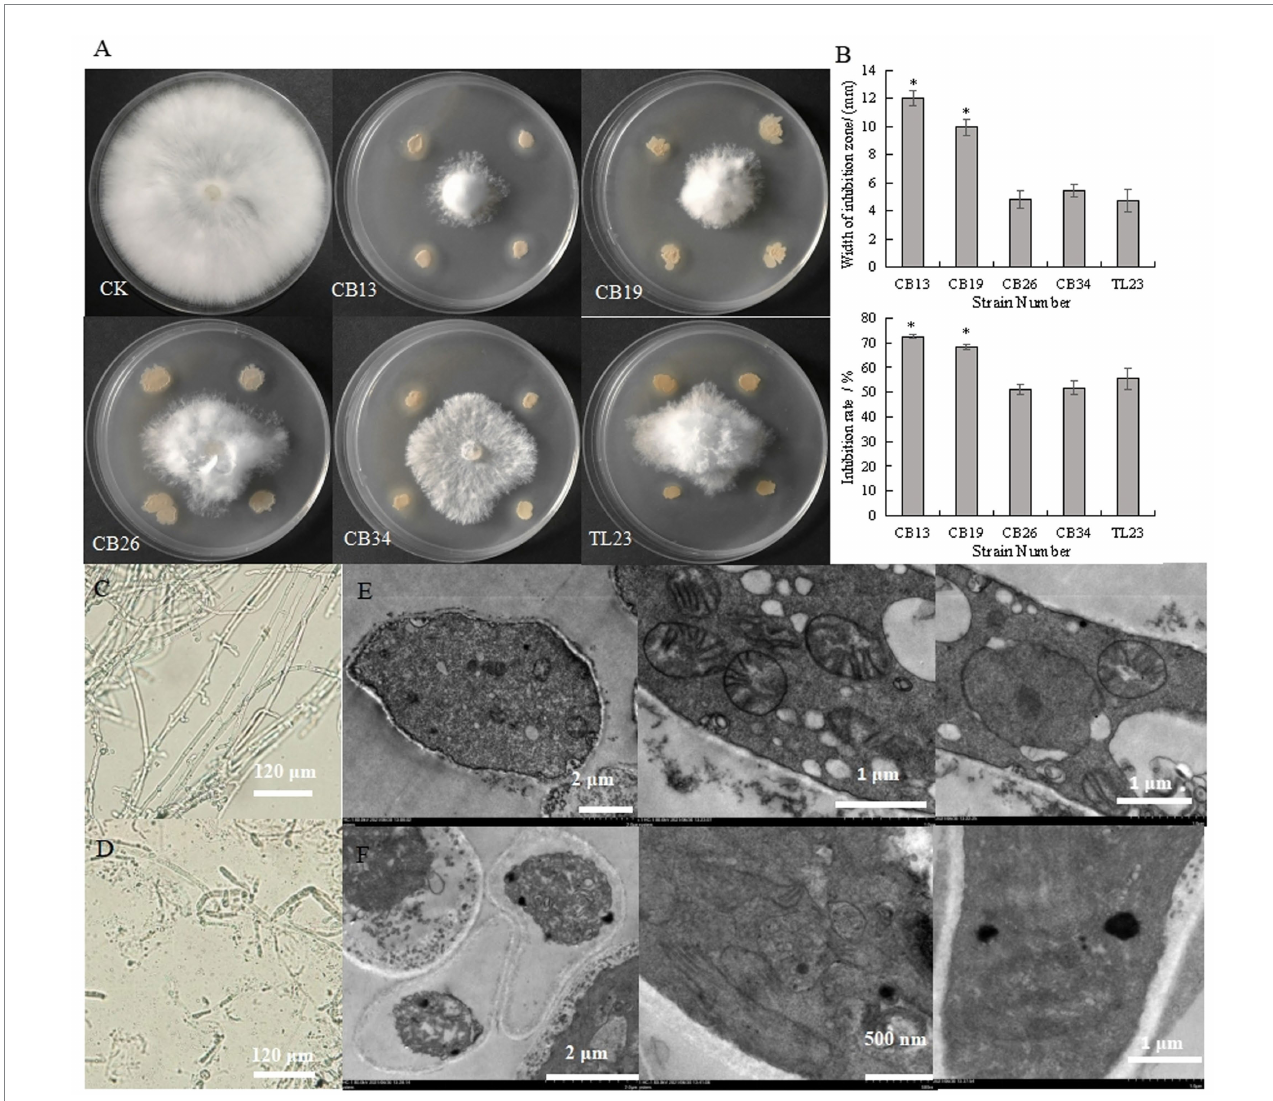
FIGURE 1 Inhibitory effect of antagonistic bacteria on the radial growth and mycelium cells of Sclerotium rolfsii . (A) Inhibitory effect of antagonistic bacteria on the mycelia growth of S. rolfsii ; (B) width of inhibition zone and inhibition rate of antagonistic bacteria against S. rolfsii ; (C) The structure of normal S. rolfsii mycelium observed via light microscopy; (D) The structure of S. rolfsii mycelium cultured with Bacillus velezensis CB13 observed via light microscopy. (E) The structure of normal S. rolfsii mycelium cells, mitochondria, and cell nuclei observed via transmission electron microscopy; (F) The structure of S. rolfsii mycelium cells, mitochondria, and cell nuclei cultured with B. velezensis CB13 observed via transmission electron microscopy. Data are the means ± SE of three repeated experiments. Significant differences are shown using asterisks (* p < 0.05, ** p < 0.01, *** p < 0.001). Mycelia were cultured at 28 ° C for 5